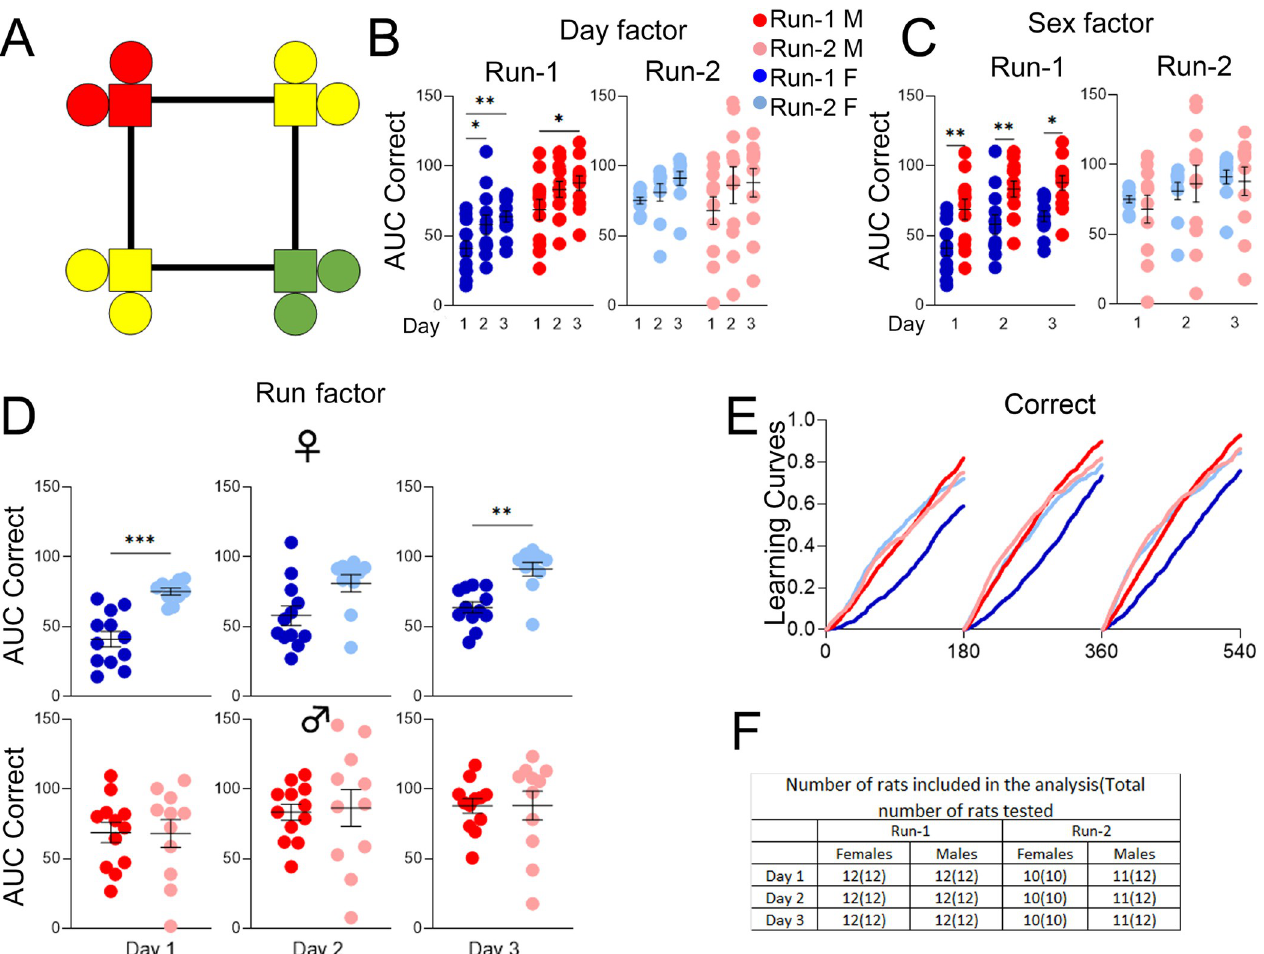
Fig 5. Place reversal, cohort A. (A) Example of correct (green) and incorrect (yellow, or red highlighting the previously correct corner) corner layout for a rat assigned to corner 4 during place learning. (B) Day factor, (C) Sex factor and (D) Run factor comparisons of area under the curve (AUC) for correct visit activity curves of individual animals by sex, program day, and Run. (E) Activity curves showing the fractional accumulation (y-axis) of correct visits over drinking session time (x-axis), reset every 180 minutes, by sex and Run. (F) For Run-1, 12 male and 12 female rats were tested. All 24 rats were included in the analysis of Run-1. For Run-2, 12 male and 10 female rats were tested, since two females died during the time between Runs. One male was excluded from Run- 2 analysis because it visited corners less than 25 times during all 3 drinking sessions. All data represented as mean ± SEM ( � p < 0.05, �� p < 0.01, ��� p < 0.001, ���� p < 0.0001). See Tables 6 and 7 for statistical analysis. Males (M or ♂ ) are colored as red (Run-1) and light red (Run-2). Females (F or ♀ ) are colored as blue (Run-1) or light blue